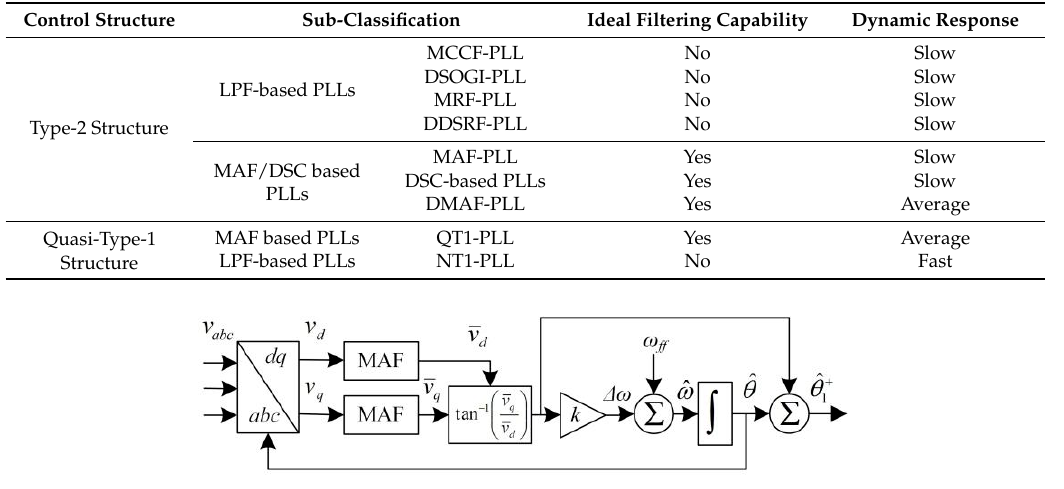
Table 1. Performance comparison between some typical PLLs.